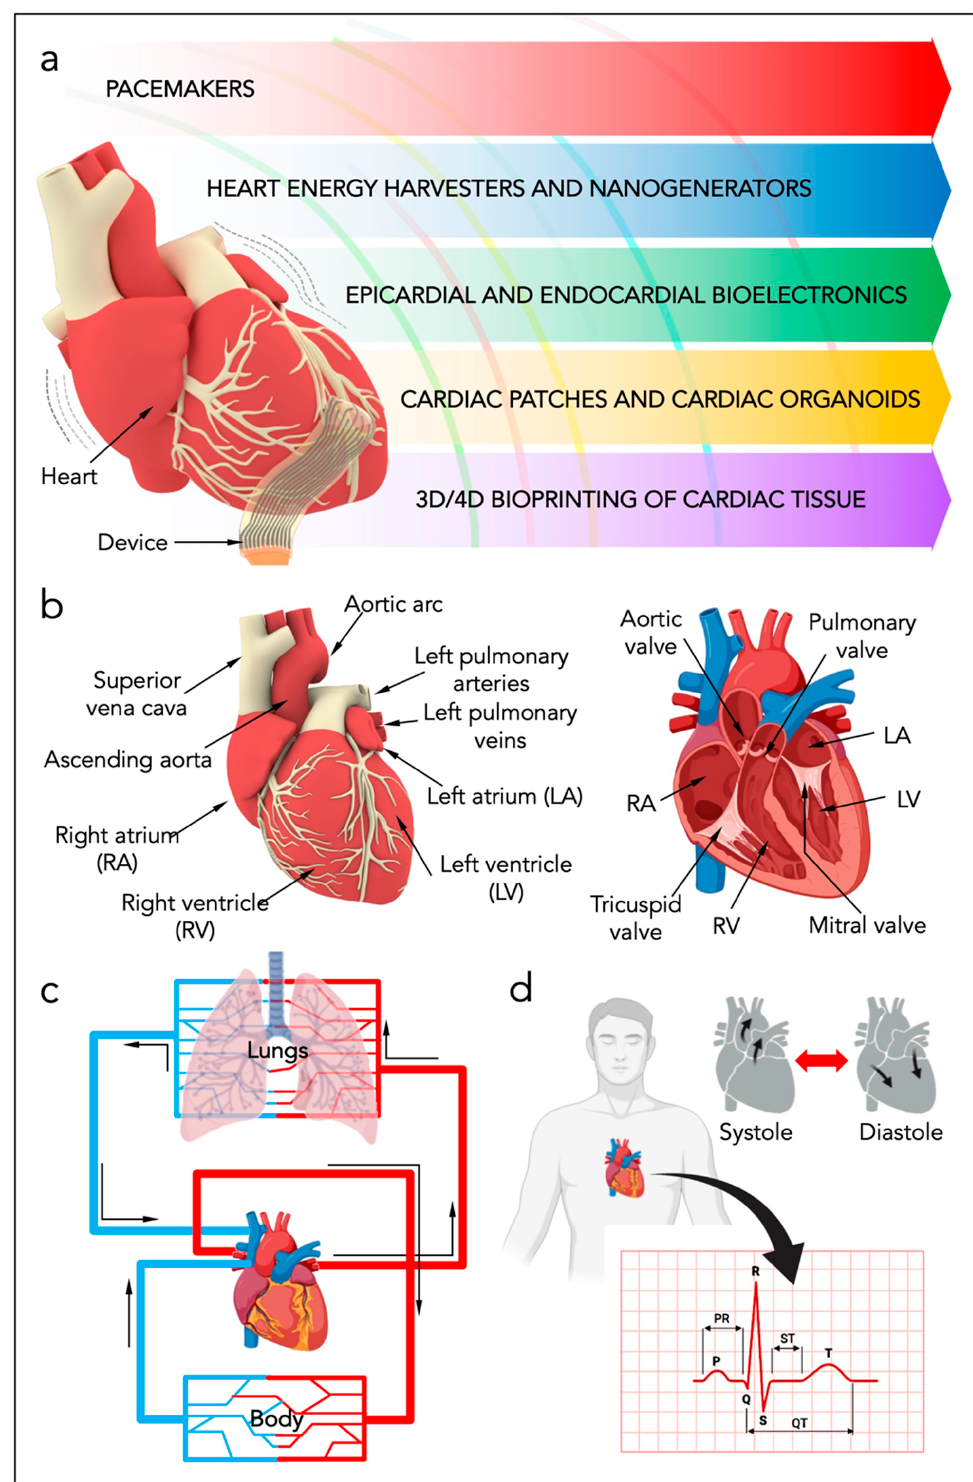
Figure 1. ( a ) Cardiac devices described in this review: pacemakers, heart energy harvesters and nanogenerators, epicardial and endocardial bioelectronics, cardiac patches and cardiac organoids, and 3D/4D bioprinting of cardiac tissue. ( b ) Simplified illustration of the heart anatomy. ( c ) Illustration of blood circulation. ( d ) Hear contraction/expansion cycle and electrocardiogram (ECG) signal.